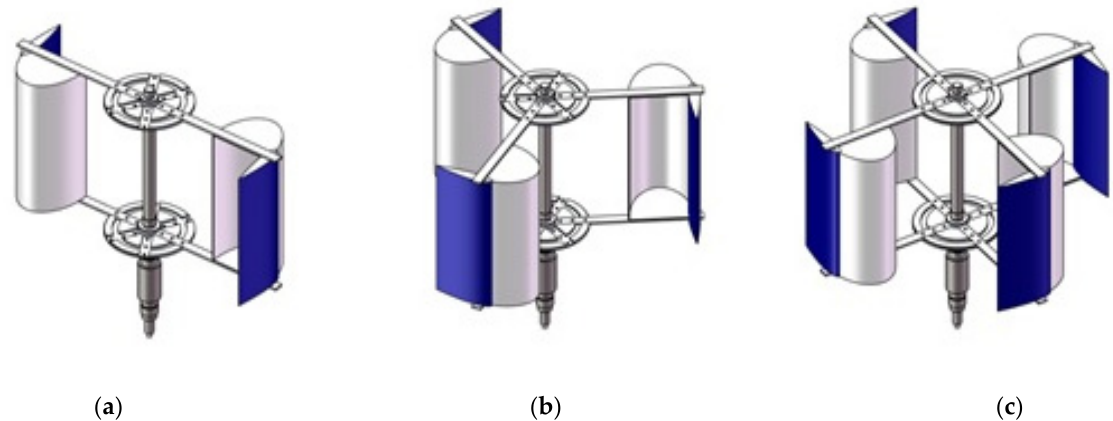
Figure 3. Three-dimensional modeling of the LDCS model: ( a ) 2-bladed LDCS; ( b ) 3-bladed LDCS; ( c ) 4-bladed LDCS.